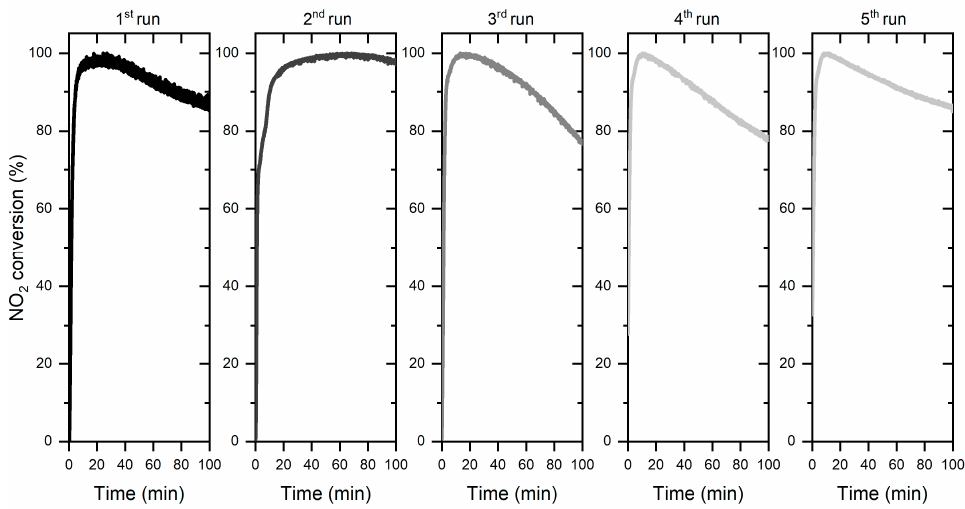
Figure 10. Cycling test of the photocatalytic NO 2 removal using WO 3 /S-doped g-C 3 N 4 .